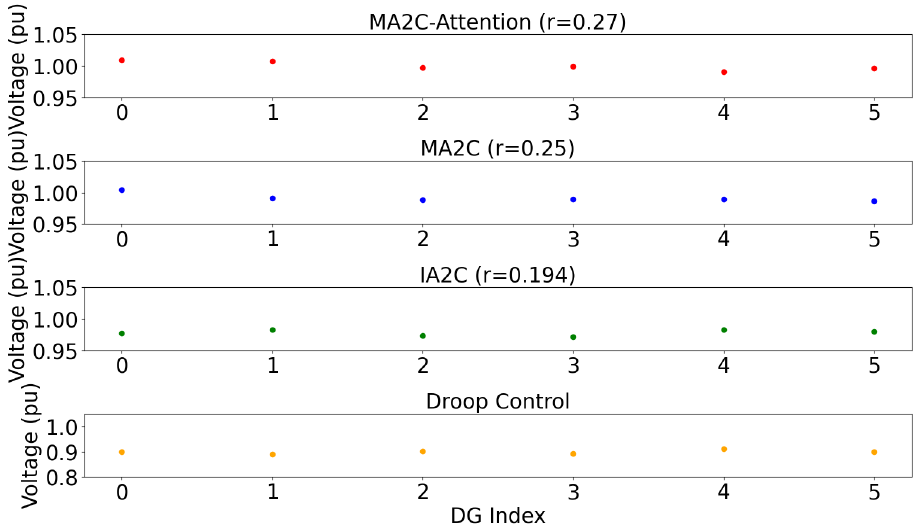
Figure 6. The voltages distributions under different